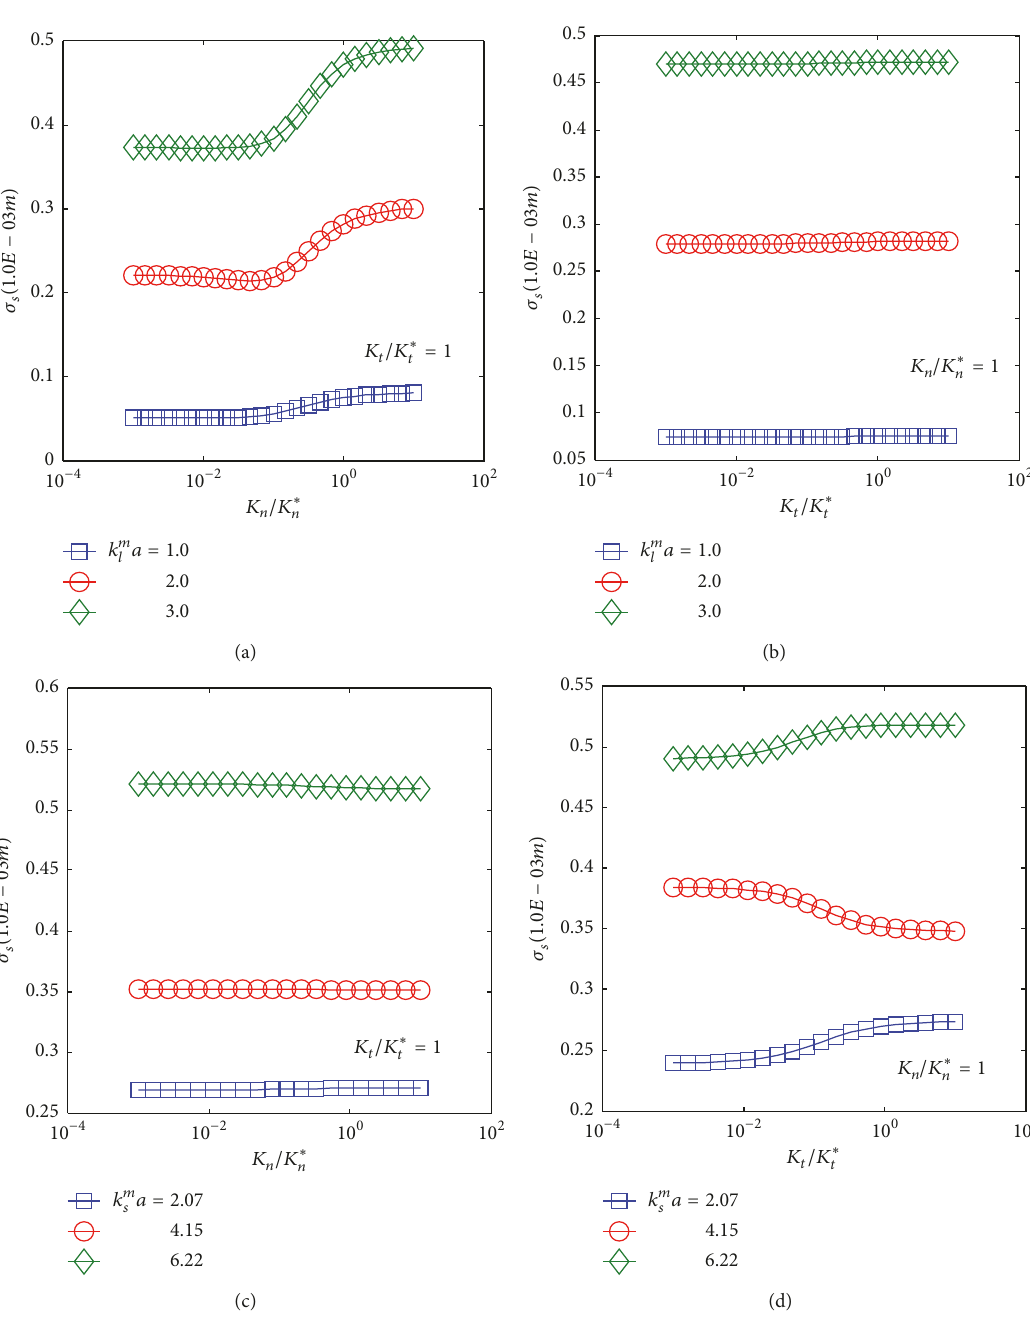
The corresponding results under the SV-wave incidence are plotted in Figure 12. Results show that 𝜎 𝑠 is sensitive to 𝐾 𝑛 as 𝛼 is larger, as Figure 12(a) shows. In contrast, 𝜎 𝑠 becomes sensitive to 𝐾 𝑡 for smaller 𝛼 , as shown in Figure 12(b). Fig- ure 12(c) shows the sensitivity of 𝜎 𝑠 to both 𝐾 𝑛 and 𝐾 𝑡 under the SV-wave incidence. Comparison of the results in Figures 11(c) and 12(c) indicates that when 𝛼 is small, the P-wave inci- dence at higher frequencies is more applicable to evaluate the changing of the stiffness of the imperfectly bonded